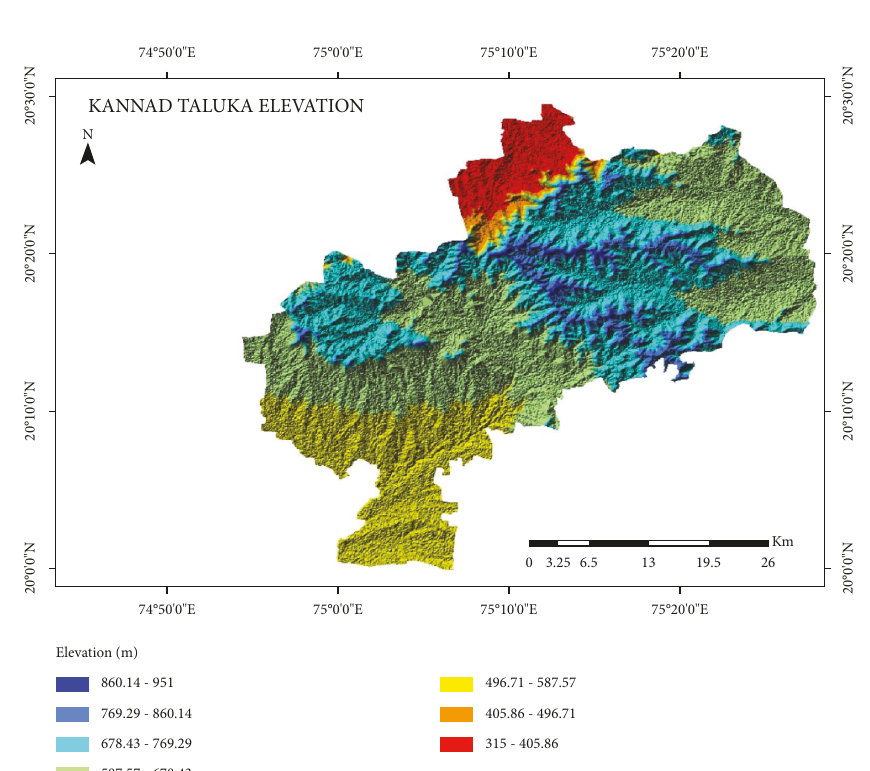
Figure 3: DEM map of Kannad taluka.